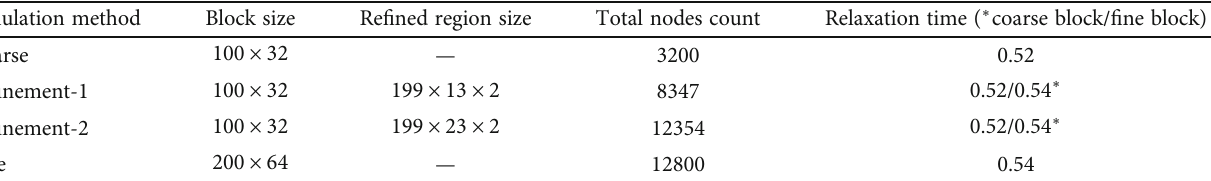
Figure 6: Physical model. Table 2: Parameter sets.